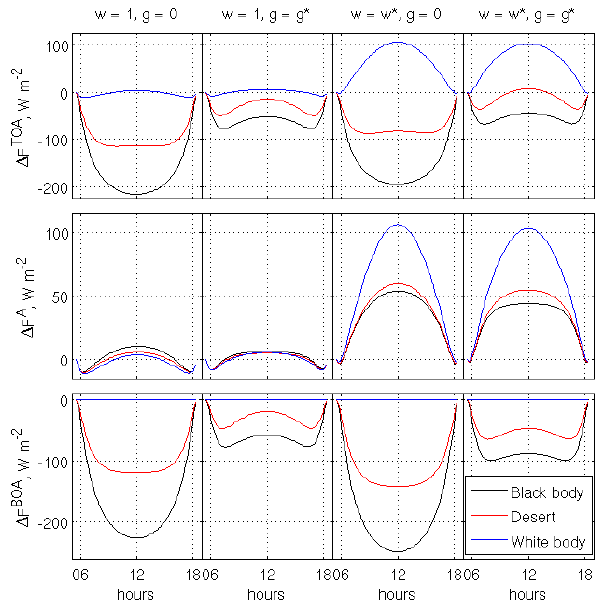
Figure 14. Broadband SW albedo for desert (blue), coastal plain (red) and ocean (black), with diurnal cycle (lines with stars) and fixed solar zenith angle (circles) averaged over the range of consid- ered optical